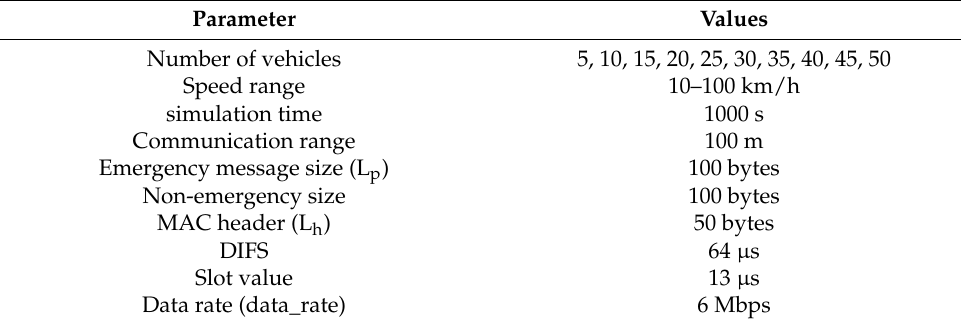
Table 4. Simulation